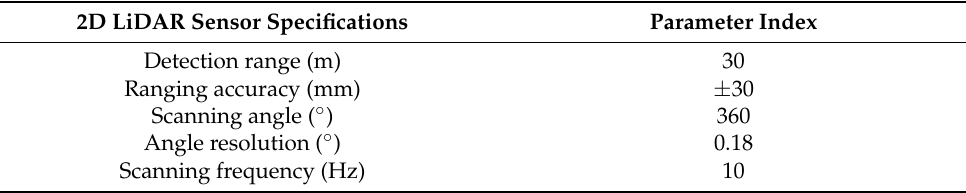
Table 1. Two-dimensional LiDAR sensor parameters.